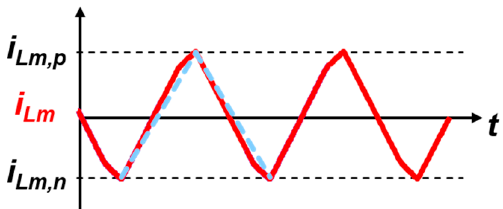
Figure 9. The magnetizing current waveform (red line) and the approximate triangular waveform (blue dashed line).